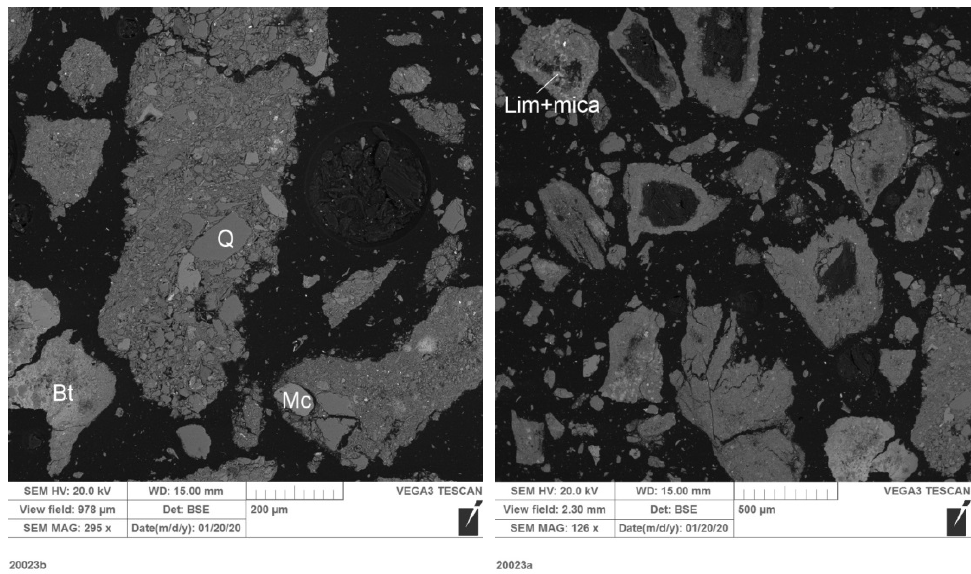
Figure A4. SEM micrograph of Sample GGS2-11-4. Fragments of quartz (Q)—potassium feldspar (Mc) in clay (kaolin-hydromica) cement, individual minerals do not differ. Light thin spots are clumps of Fe + Ti oxides. In clay cement, iron is evenly distributed in the form of films around clay particles (Lim), individual minerals are not distinguished. Voids in some clay particles—chipping. No calcium carbonates were found in cement.